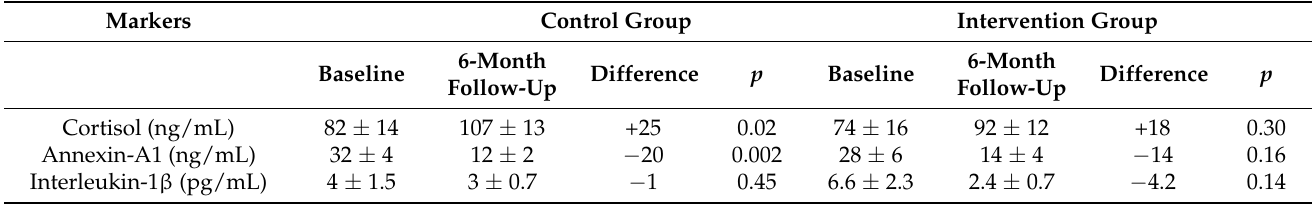
Table 6. Summary data of blood sample analyses at baseline and 6-month